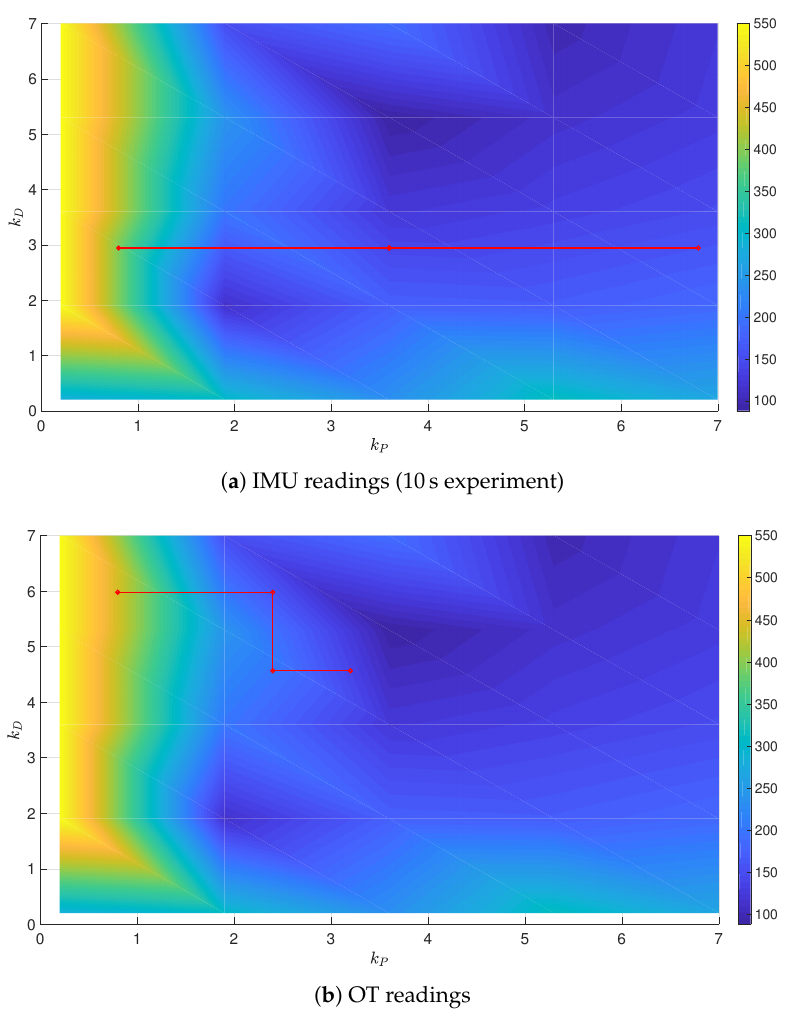
Figure 10. Minimum-time trajectory surface with partial results of